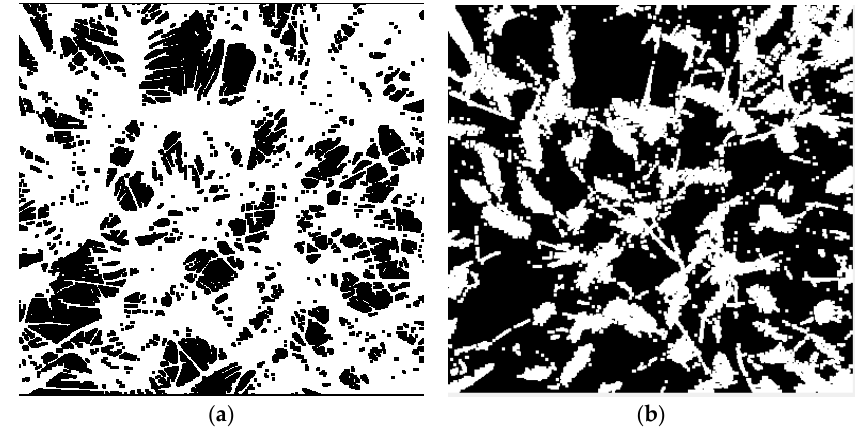
Figure 4. Image contrast before and after morphological filtering. ( a ) Before morphological filtering, ( b ) after morphological filtering.